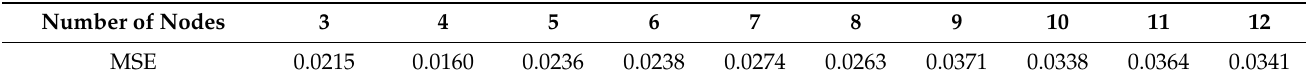
Table 1. The number of hidden nodes and the values of